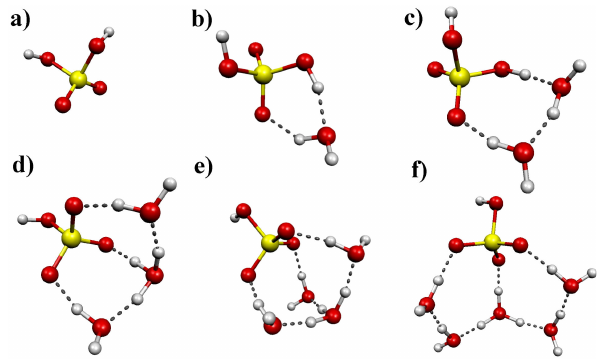
Fig. 2. The most stable structures with respect to the for- mation free energy 1G (at T = 298 . 15K and P = 1atm) for clusters consisting of one sulfuric acid with ammonia and 0–